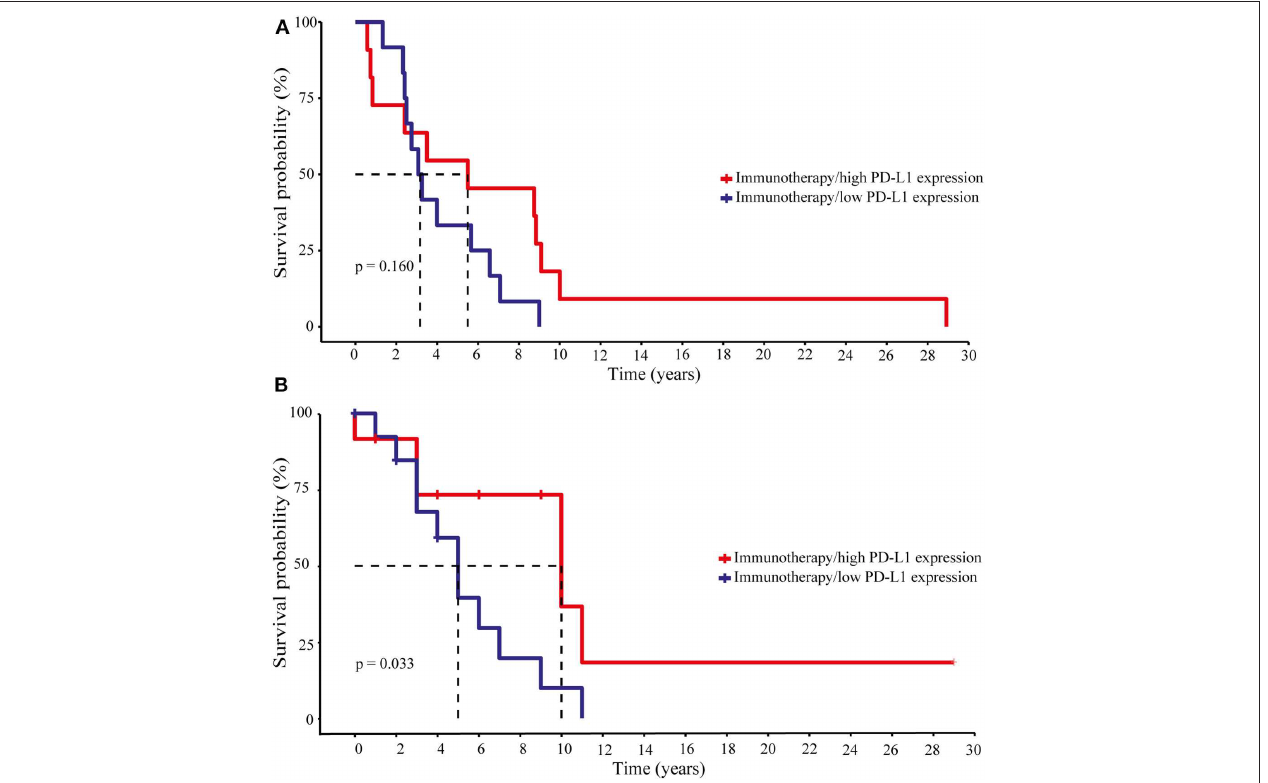
FIGURE 7 | Disease progression and survival analyses of melanoma patients under immunotherapy with respect to intracranial PD-L1 expression. Patients were divided into two groups, “high” and “low” PD-L1 expression due to the median PD-L1 expression level. (A) Progression-free survival. Long-rank test statistics show no differences in the progression-free survival for patients with high and low PD-L1 expression (Log-rank p -value 0.160). (B) Overall survival. According to the Kaplan–Meier curve patients with high PD-L1 had a greater benefit from immunotherapy and showed a better overall survival (Log-rank p -value 0.033). Dotted lines indicate the 50% survival probabilities for both